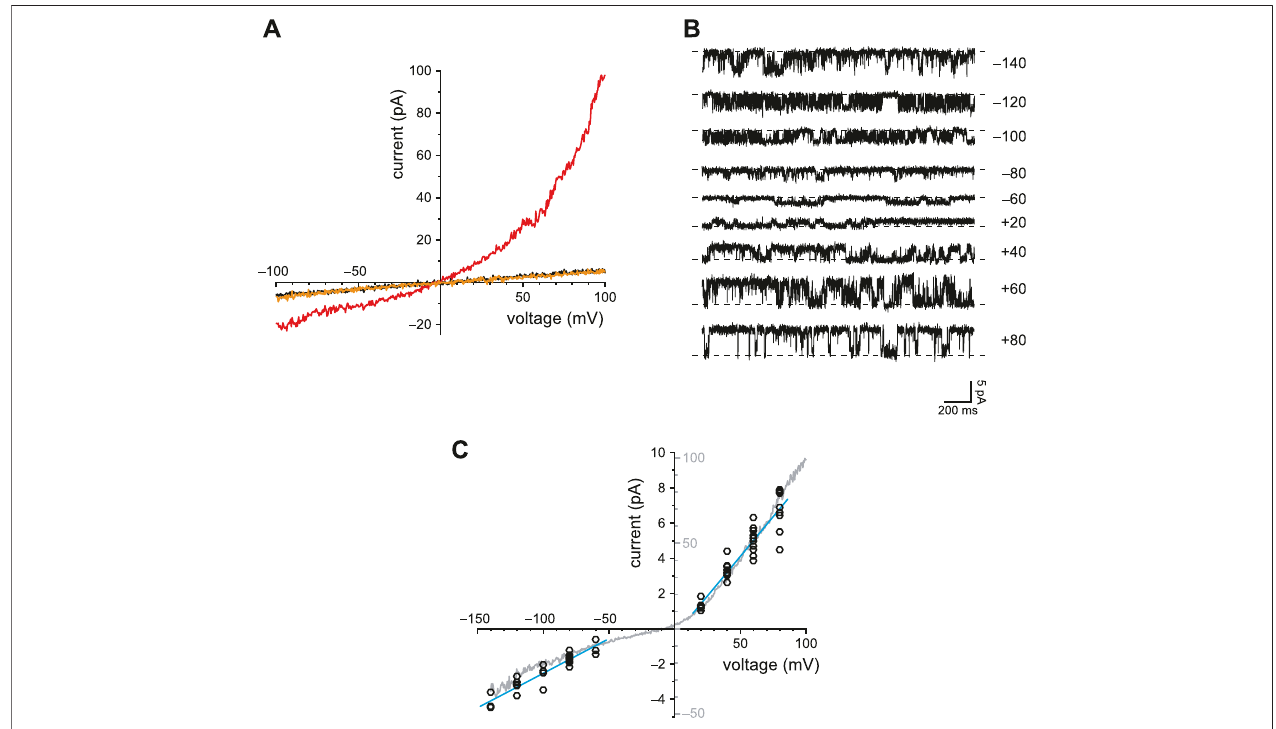
FIGURE 7 | Ciliary TRPV4 activity. (A) In a single cilium, the ciliary current-voltage relation was measured in the absence of the TRPV4 agonist GSK1016790A (black), in its presence (50 nM, red), and again in its absence (orange). (B) Single-channel current fl uctuations observed in the presence of 50 nM GSK1016790A at the membrane potentials shown. (C) Single-channel current-voltage relation from − 140 to +80 mV (open circles). The internal solution contained 50 nM GSK1016790A. At each voltage, single-channel current was measured in from 3 to 11 cilia. The blue lines show the best linear fi ts and have slopes (single-channel conductances) of 39 pS( − 140to − 60 mV)and90 pS(+20to+80 mV).Therelationshowningrayistheaverageofthemacroscopiccurrentsactivatedby50 nMGSK1016790Aineachof 8 cilia. Leak currents measured in the absence of GSK1016790A were subtracted. The current scales of the single-channel and macroscopic currents are different and are both shown on the y -axis. The scales were chosen to facilitate comparison ofthe single-channel and macroscopic current-voltage relations. In all parts ofthis fi gure, Ca 2+ was buffered with 0.25 mM BAPTA.